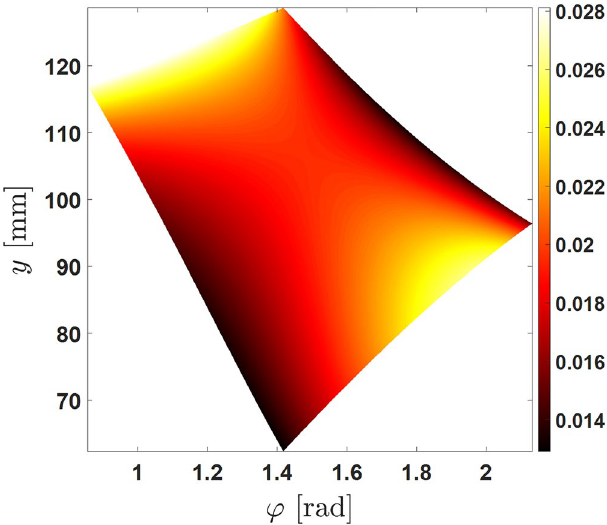
Figure 4. Manipulability of the mechanism in the given workspace. The workspace of the 2 DOF mechanism can be visualized with this graph. The manipulator workspace is configured as described in Table